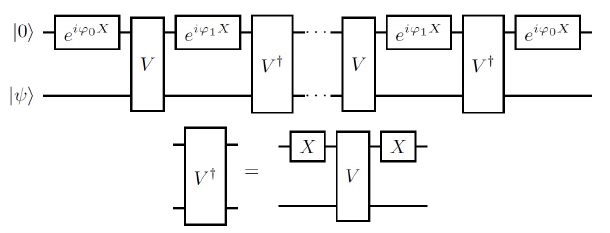
FIG. 7. The variant of QETU with an oracle implementing the controlled forward and backward time evolution. The implemen- tation of V † can be carried out by conjugating V with Pauli X gates acting on the first qubit and the Pauli X gate can be first combined with the phase rotation as e i ϕ X X = ie i (ϕ + π/ 2 ) X